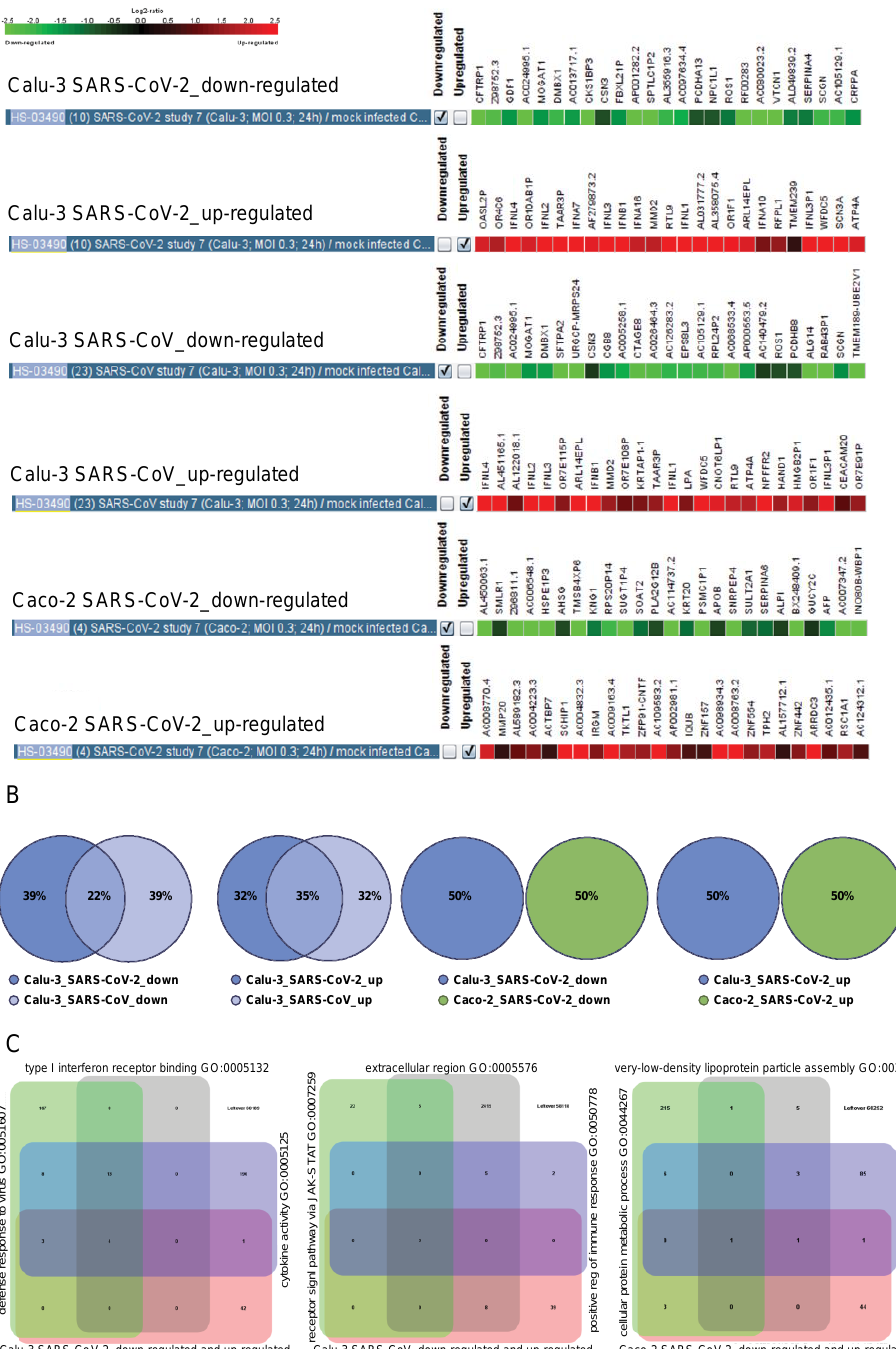
Figure 6. The 25-gene specific signatures for Calu-3 treated with SARS-CoV-2 or SARS-CoV and Caco-3 treated with SARS-CoV-2. ( A ) GENEVESTIGATOR-based analysis identified the 25-gene specific signatures of down-regulated and up-regulated genes for the indicated conditions. ( B ) R-based comparisons are visualized by scaled Venn diagrams. The color code indicates the condi- tion — the cell type (Caco-2 or Calu-3) and the virus type (infection with SARS-CoV-2 or SARS-CoV). The rounding up or rounding off of the values was performed by the R program au- tomatically, according to standard mathematical rules; therefore the total sum of the three values in a Venn diagram might not be equal to 100. ( C ) The GENEVESTIGATOR-based analysis aligned the genes that are part of the signatures shown in ( A ) to the biological process using the Gene Set En-